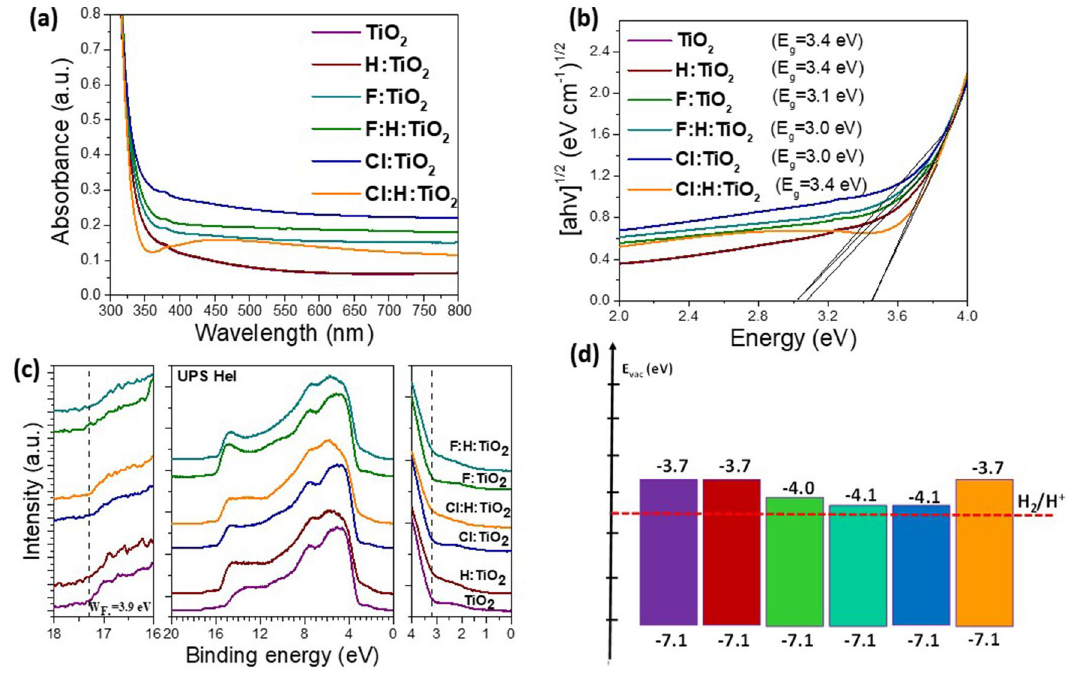
Figure 5. ( a ) UV–Vis absorption spectra and ( b ) the corresponding Tauc plots of all samples. ( c ) UP spectra (middle), the high BE cut-off (left) and the valence band maximum (VBM) (right) regions are presented for all the samples. ( d ) The electronic band structure of the TiO2 samples according to UP spectra and Tauc